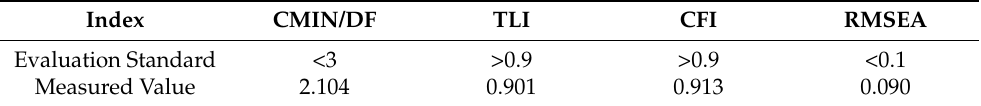
Table 5. Model adaptation indexes.